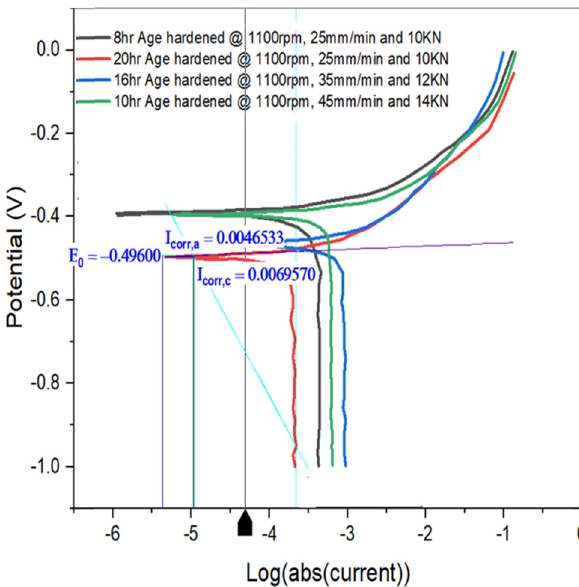
Figure 11: Tafel plot for samples AH 5 , AH 6 , AH 7 , and AH 8 .